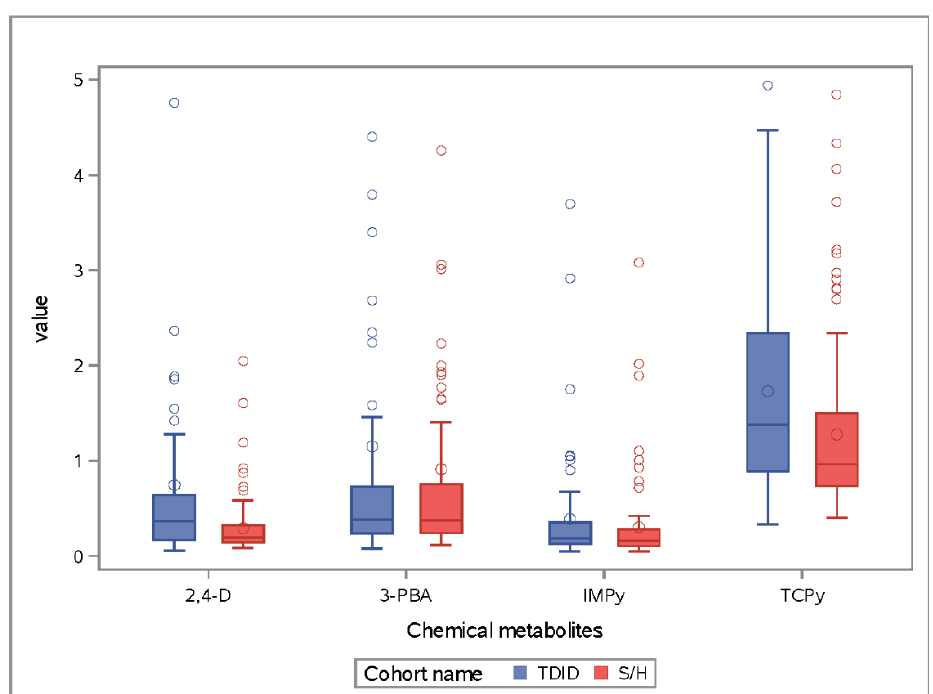
Figure 2. Comparison of four metabolites, 2,4-D, 3-PBA, IMPy, and TCPy, by cohort and by baseline sociodemographic characteristics of TDID and S/H cohort participants. ( A )Comparing concentrations of 2,4-D, 3-PBA, IMPy and TCPy in the S/H and TDID cohorts in terms of employment status.( B ) Comparing concentrations of 2,4-D, 3-PBA, IMPy and TCPy in the S/H and TDID cohorts in terms of